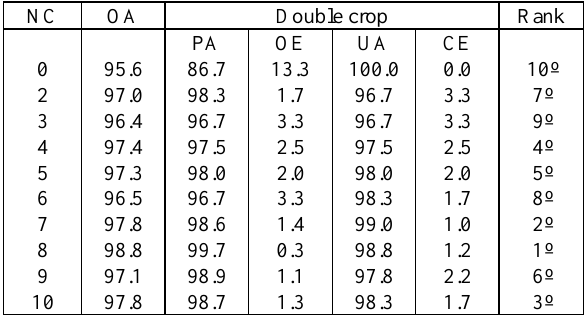
Table 2 . Accuracy results (in percentage) from cluster-based classification tests. (NC = number of clusters, OA = overall accuracy, PA = producer’s accuracy, OE = omission error, UA = user’s accuracy, and CE = commission error).